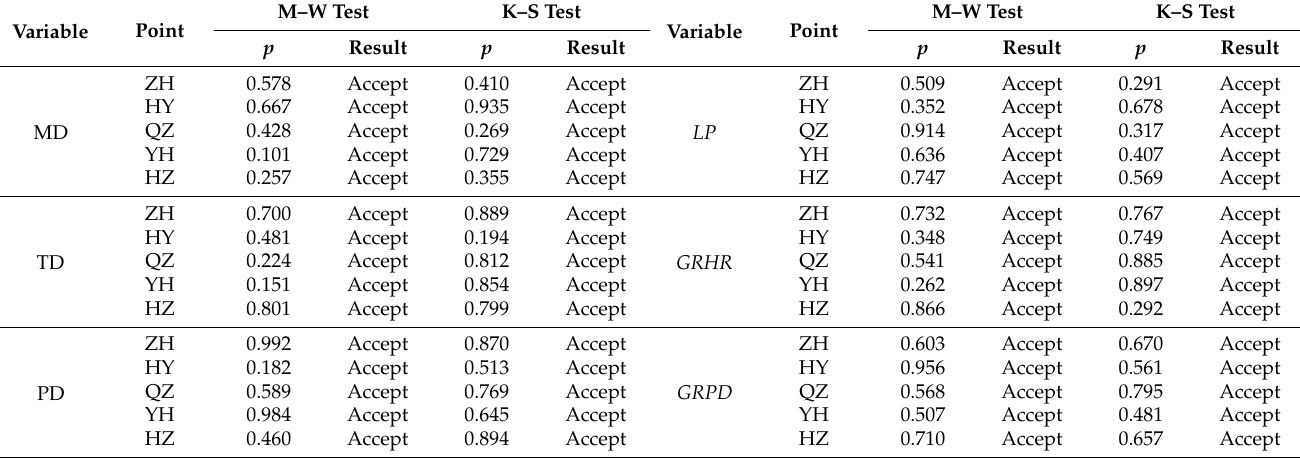
Table 3. Comparison statistical test results of DW